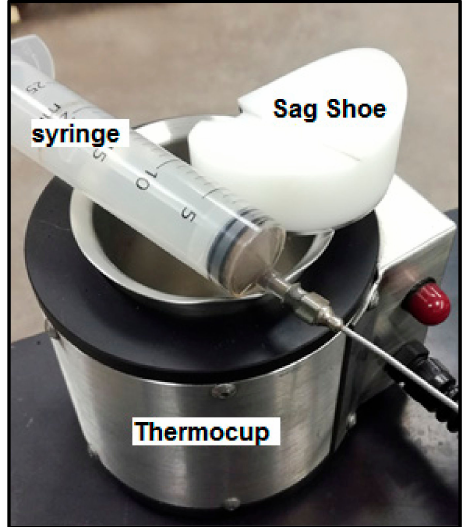
Figure 1. Basic equipment for dynamic sag test (VSST excluding the